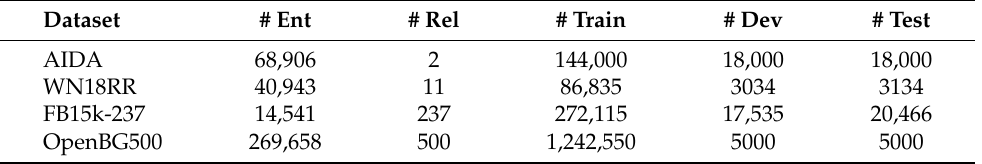
Table 1. Statistics of FB15k-237, WN18RR, and OpenBG500. # refers to the